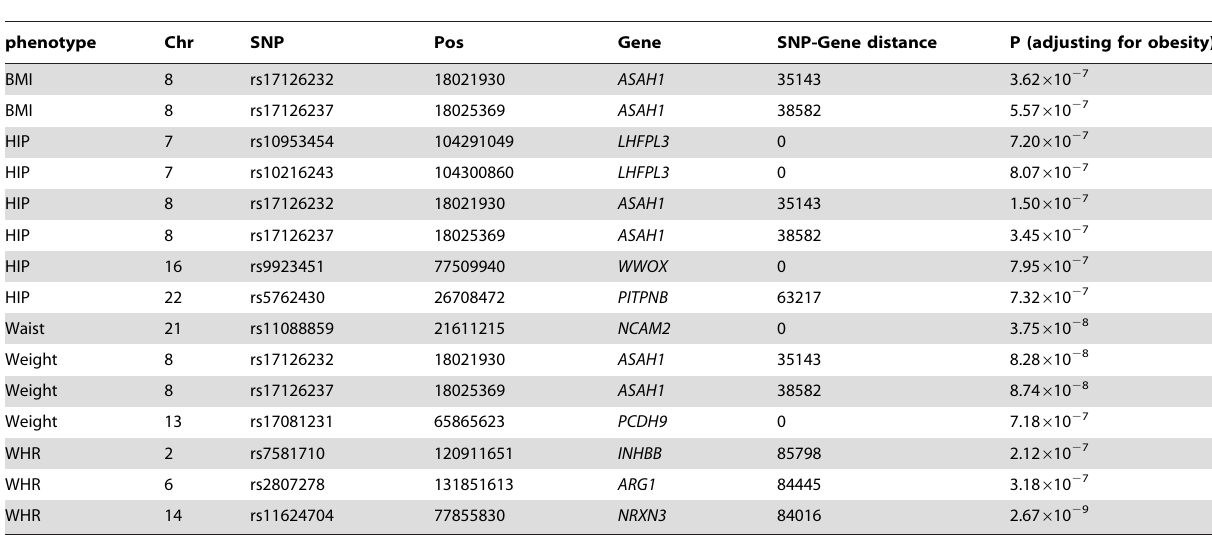
from a standing position using a stadiometer. Weight was Table 5. List of significant associations (P , 1 6 10 2 6 ) in quantitative trait